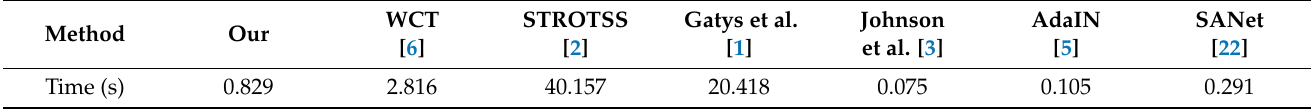
Table 4. Running time comparison between our method and six state-of-the-art methods (in seconds).